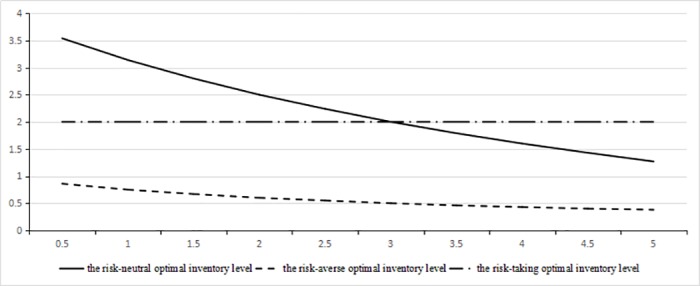
The sensitivity analysis of parameter for expiration cost e.